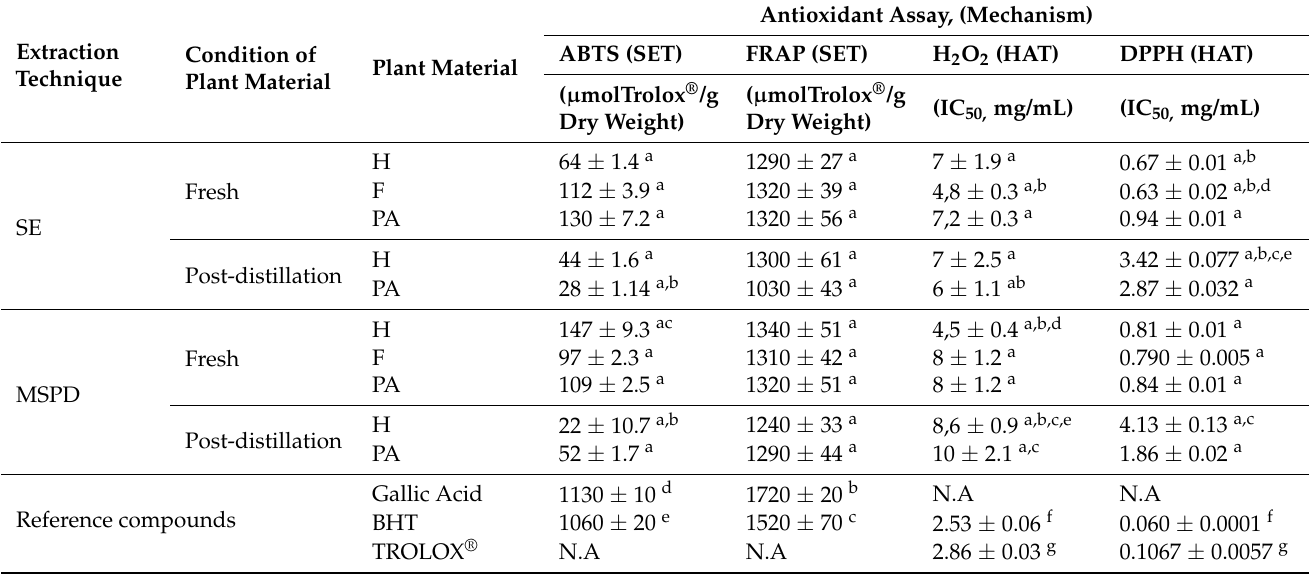
Table 3. Total antioxidant capacity for the different extracts obtained by different extraction tech- niques, plant material and plant part condition.